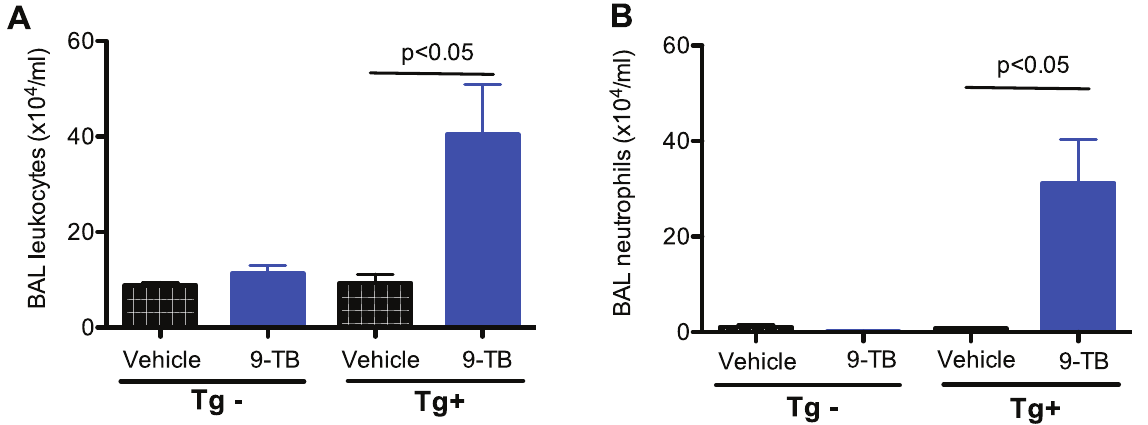
Figure 3. 9-TB treatment increases leukocytes in bronchoalveolar lavage (BAL) fluid of CC10- CA IKK b Tg + mice with saline treatment. ( A ) – total leukocytes; ( B ) – neutrophils. N=4–6 mice per group. Data are expressed as means 6 SEM.